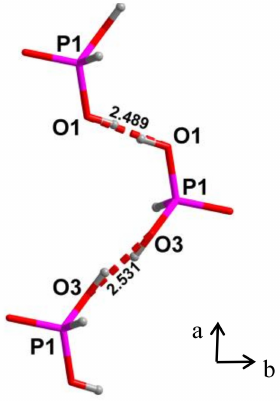
Figure 15. Fragment of the crystal structure of glycine phosphate.